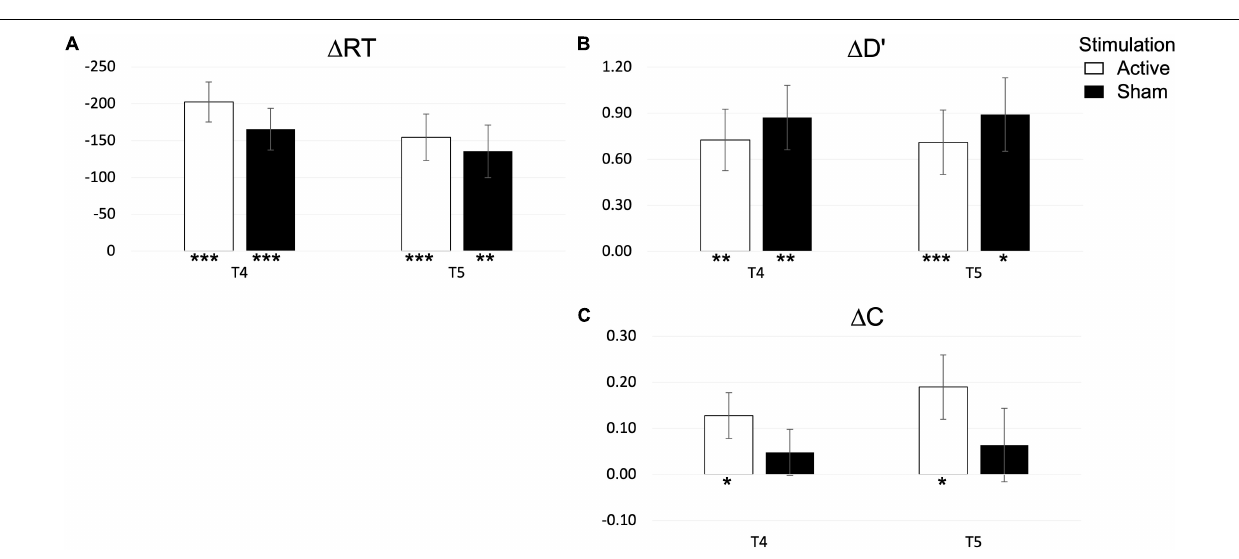
FIGURE 8 | Changes in reaction time (A) , performance (B) and bias (C) at post-test (T4) and follow up (T5) in the SNBACK task. P -values are indicated as follows: * p < 0.05, ** p < 0.01, and *** p <